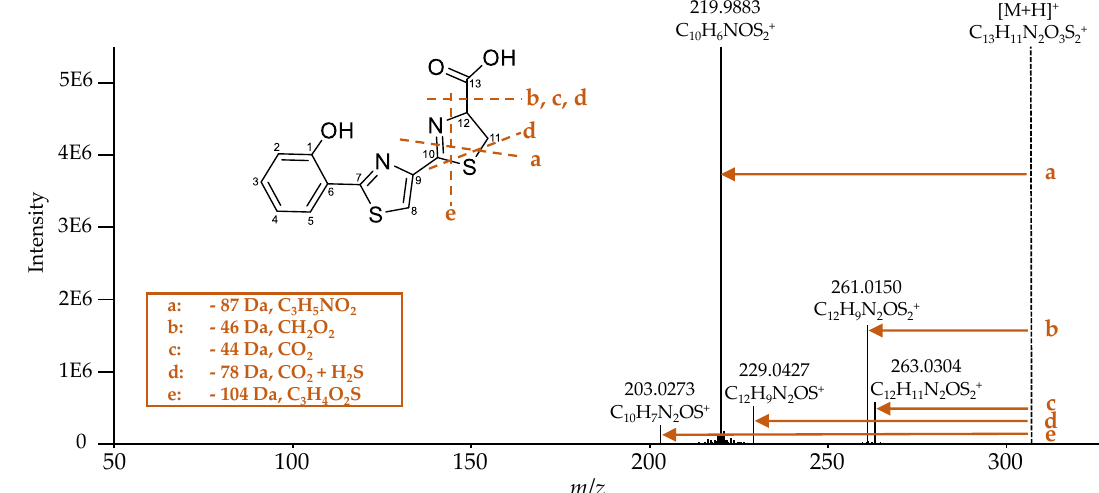
Figure 7. MS 2 spectrum of escherichelin ([M + H] + : C 13 H 11 N 2 O 3 S 2 + , calculated: m / z 307.0206, measured: m / z 307.0208, ∆ m 0.8 ppm). It corresponds to that in literature [29], which also described the same NL of 87 (fragment a), 46 (fragment b), 78 (fragment d), and 104 Da (fragment e). Additionally, under this condition of the fragmentation experiment, the NL of 44 Da (fragment c) was detected as